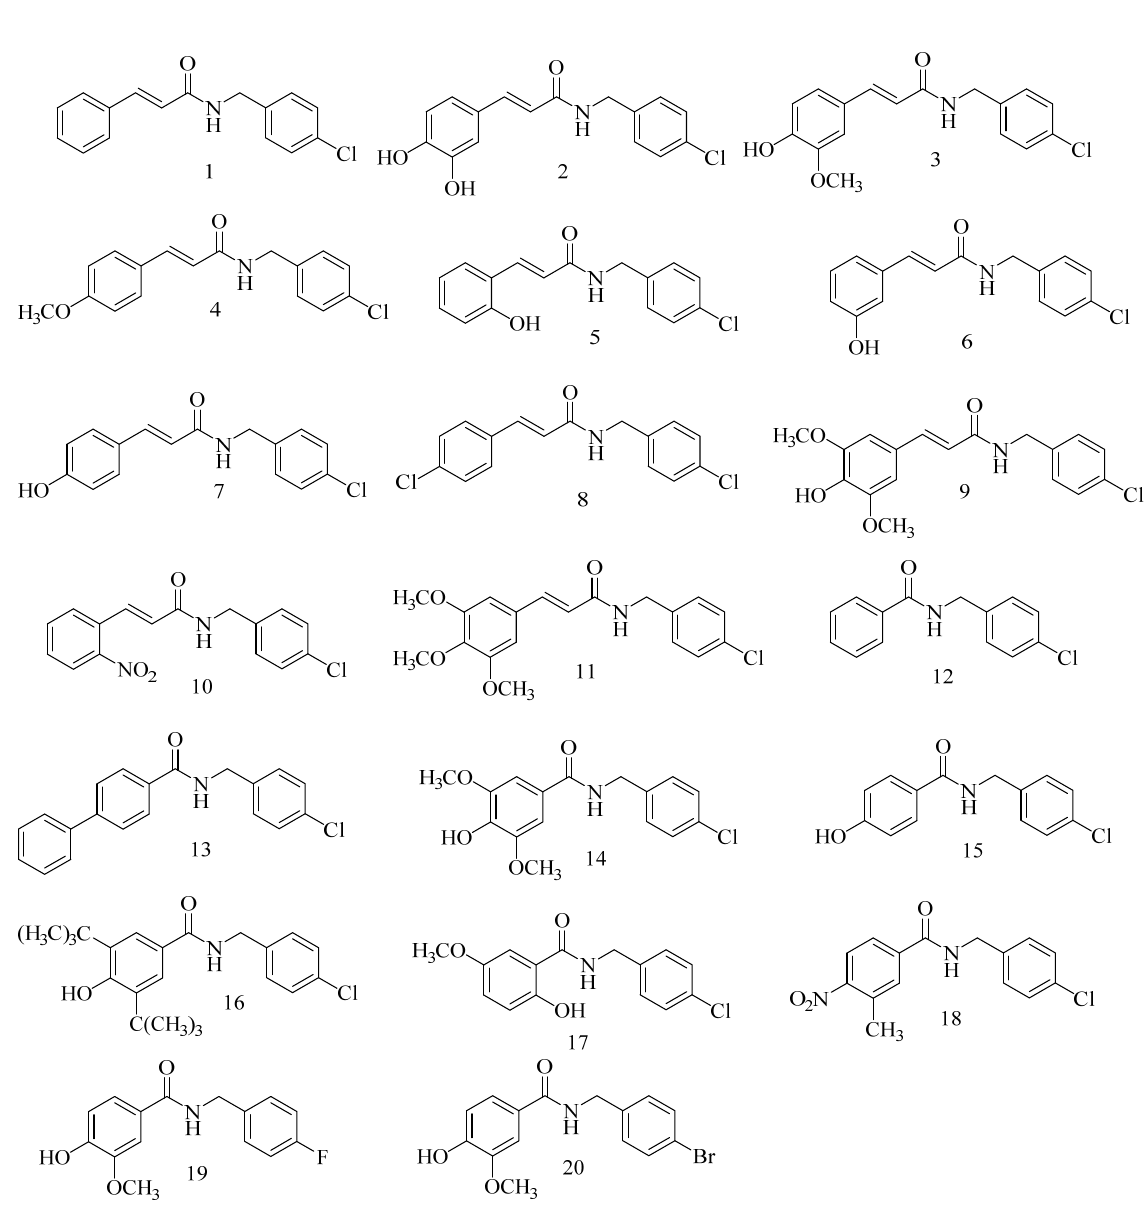
Figure 5. Halogenated amides synthetized via